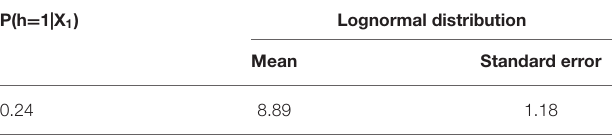
TABLE 1 | The predicted parameters (2016).